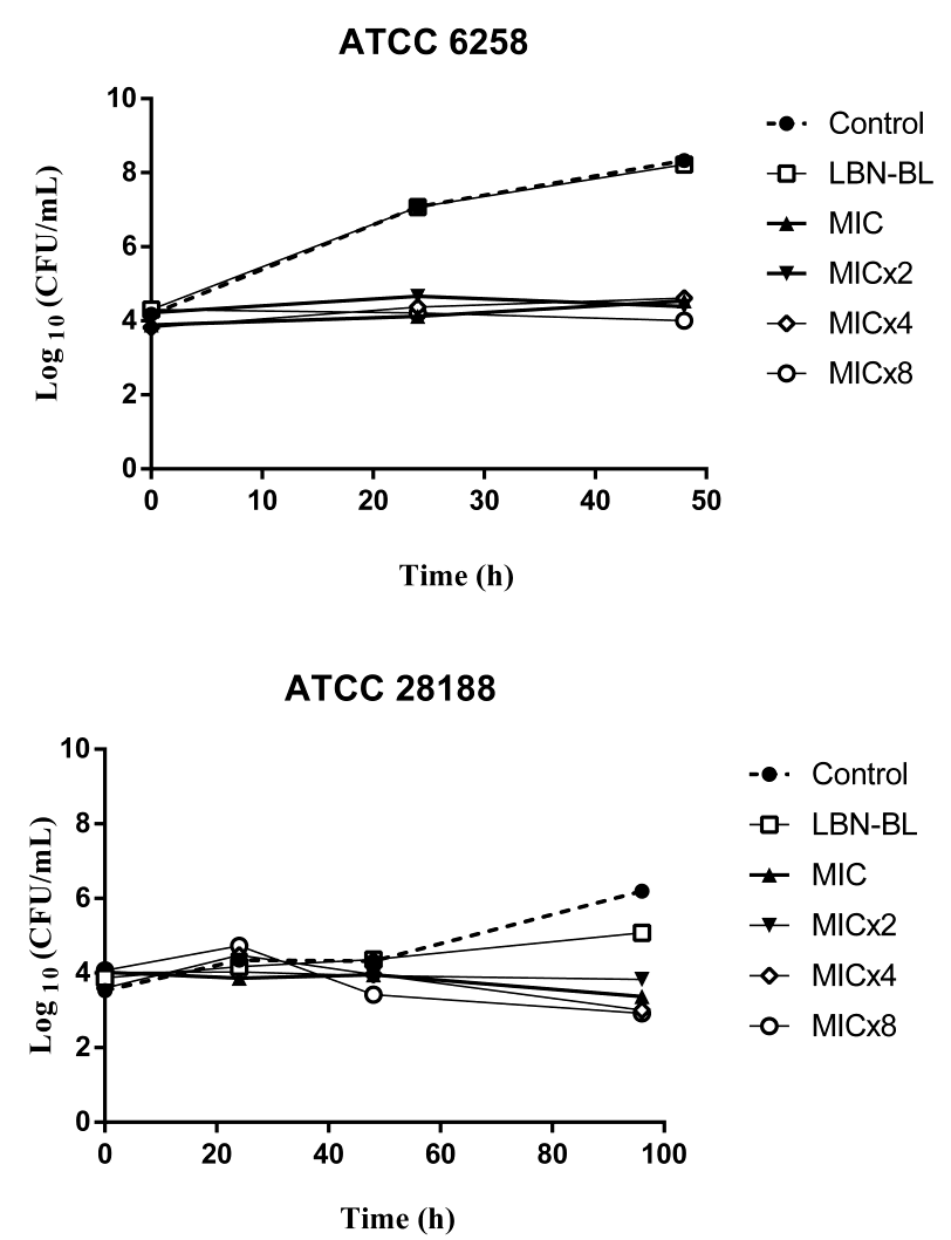
Figure 5. Log plots of killing kinetics against C. krusei (ATCC 6258) and T. rubrum (ATCC 28188) for the concentrations of the nanoformulation containing clioquinol (LBN-CQ) at MIC × 8, MIC × 4, MIC × 2, MIC, the control and the placebo nanoformulation (LBN-BL).